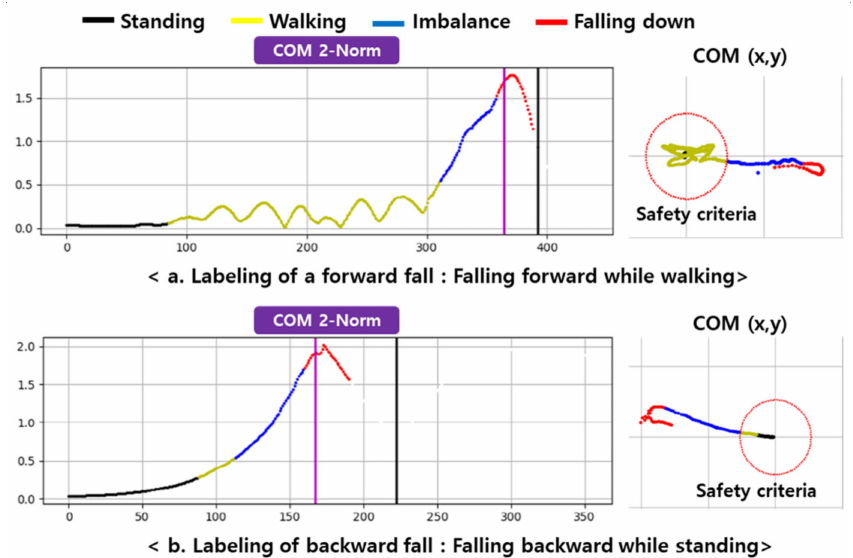
Figure 2. Examples of fall data labeling. The inverse COM is calculated and the instability increases as the value